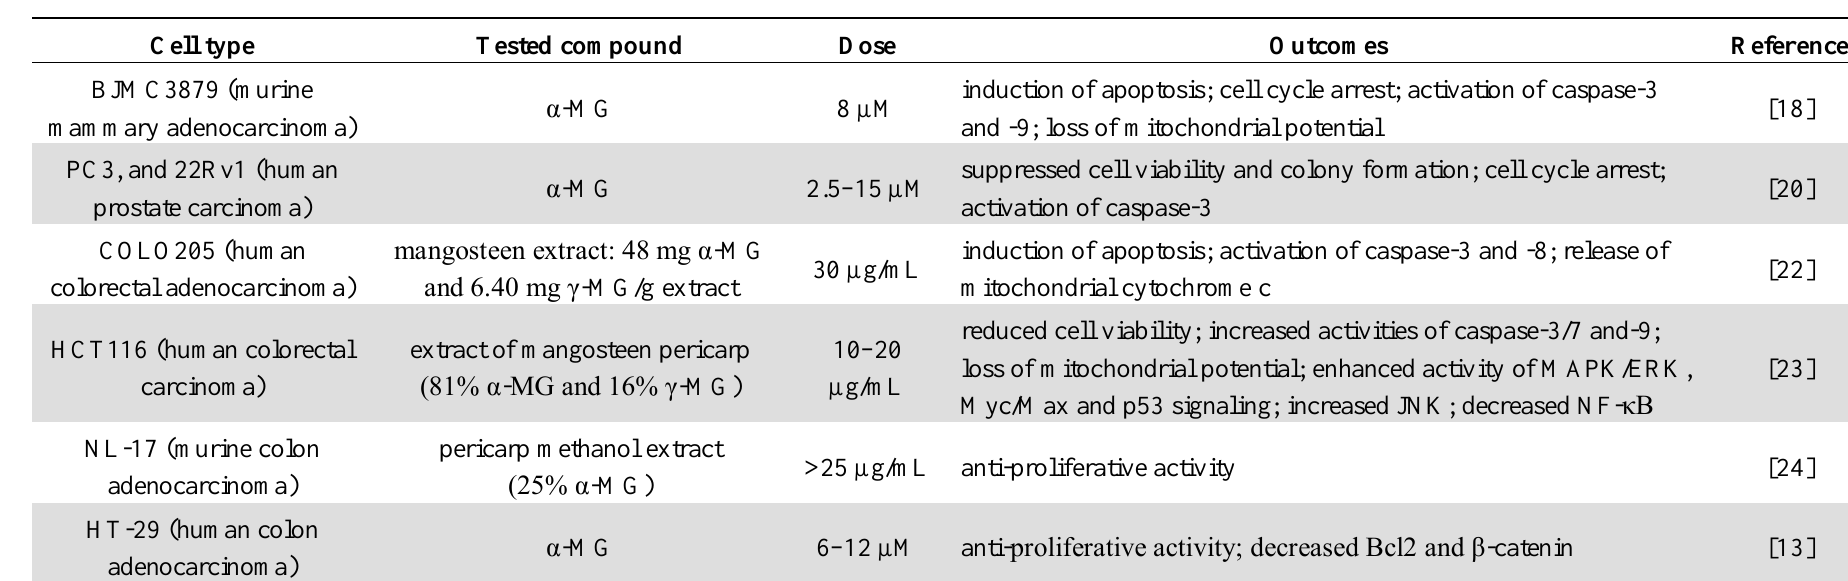
Table 3. In vitro pro-apoptotic and anti-proliferative activities of mangosteen